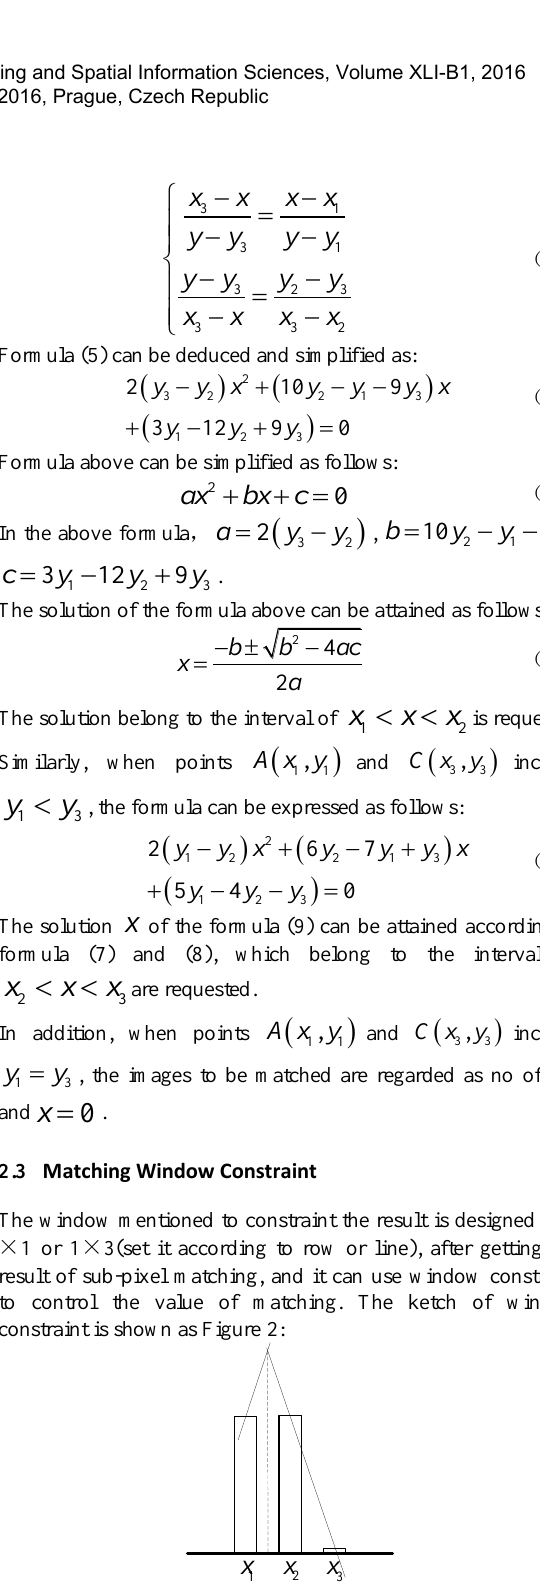
Figure 2. Window constraint sketch x , and x is far less than the peak of When the peak of 3 1 x is close to the limitation of peak x , it is shown as figure 2, 2 1 according to geometric knowledge, we know the distance of x x must be less than 0.5, so we can use this constraint deviates 2 to control the value of sub-pixel, using it to act as removed strategy of mismatching points of sub-pixel matching fractional